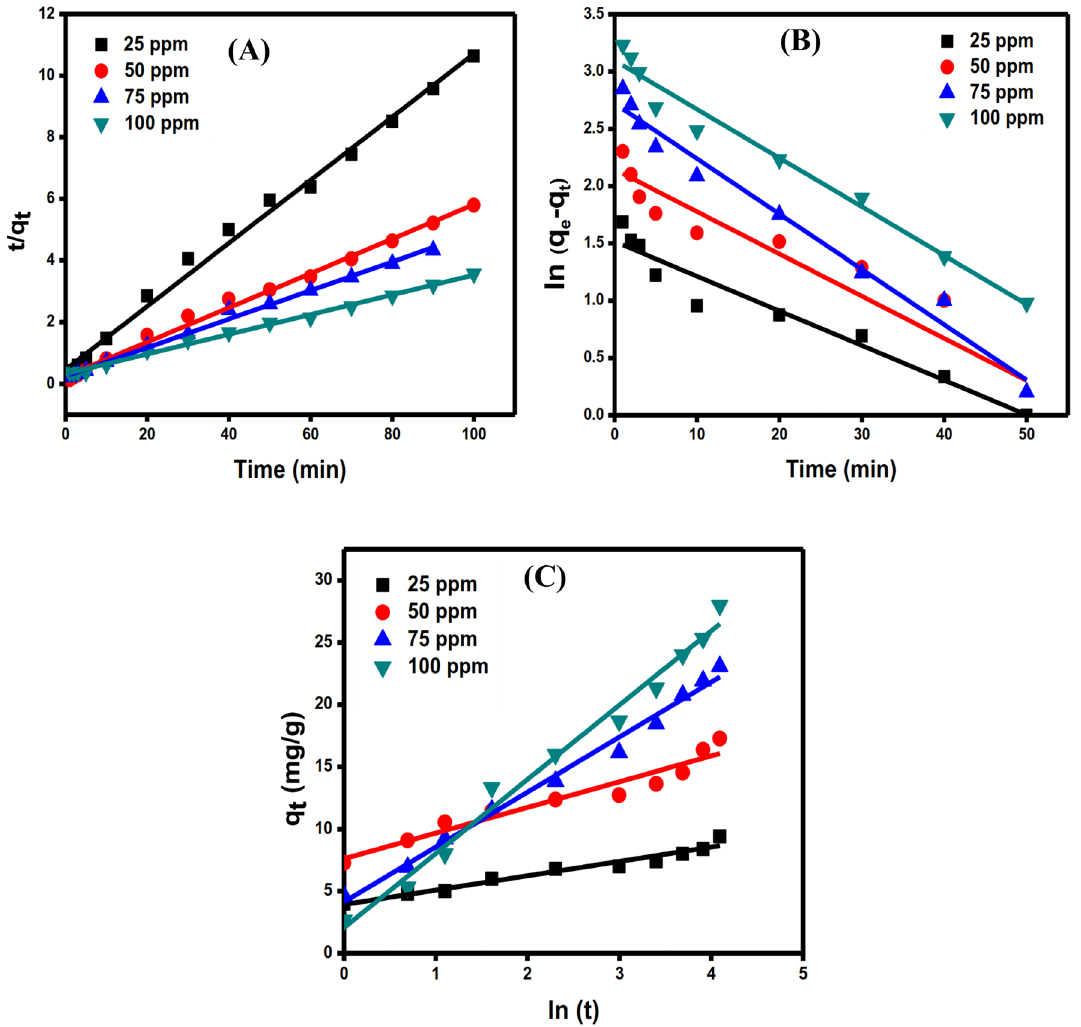
Figure 8. linear adsorption kinetic plots of pseudo 2nd order ( A ), pseudo 1st order ( B ), and Elovich ( C ) [C o = 25–100 mg L −1 , pH = 7, T = 25 °C, and dose = 0.05 g].